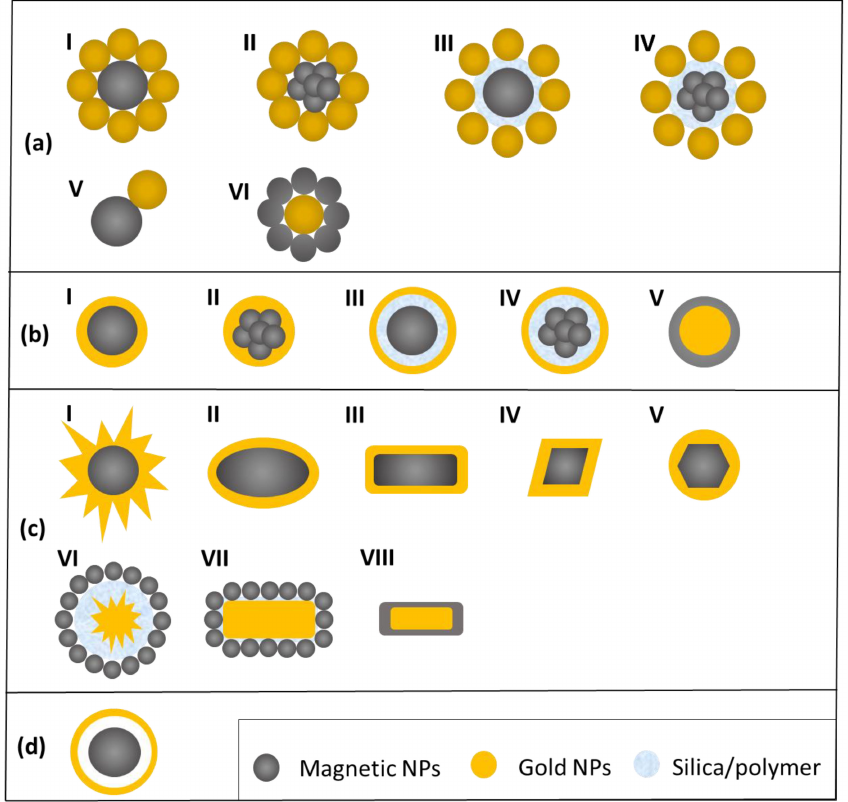
Figure 1. Examples of iron oxide-gold nanostructures: ( a ) core-satellites with different structures (I–VI), ( b ) spherical core-shell with different structures (I–V), ( c ) non-spherical core-shell with different structures (I–VIII), ( d ) hollow